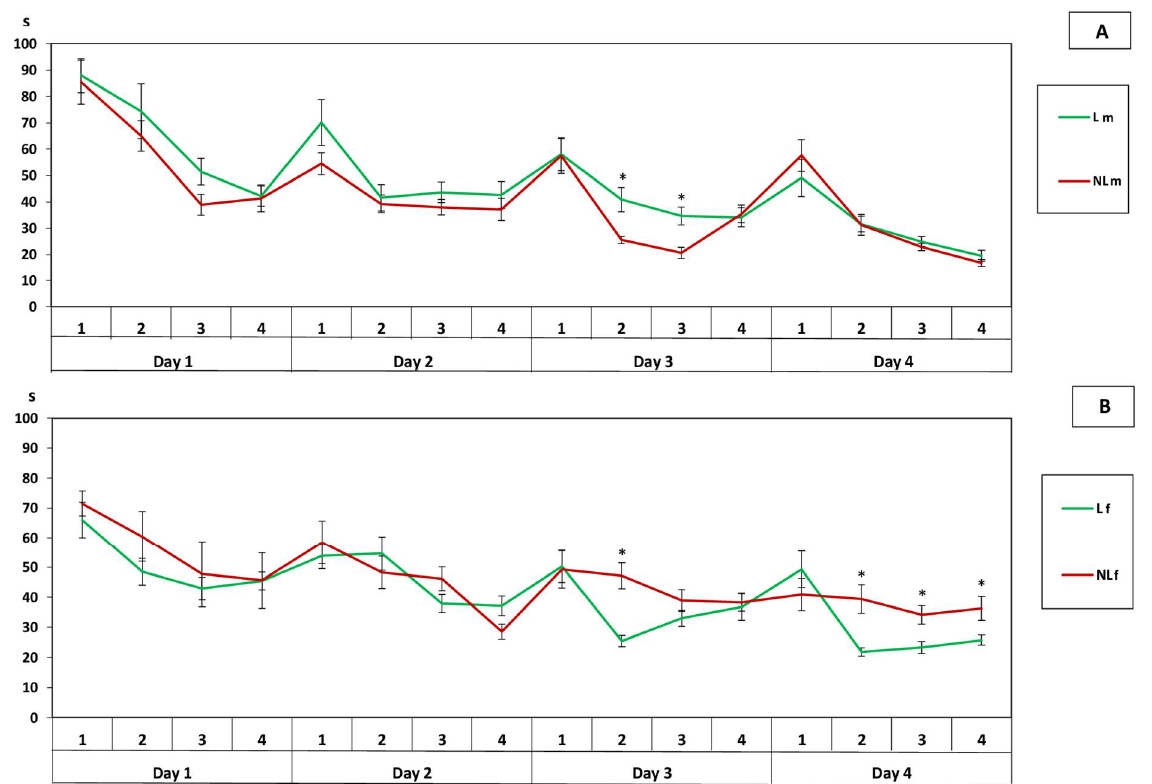
Figure 7. The latency period of reaching the underwater platform (( A )—2-month male rats; ( B )—2-month female rats). * p < 0.05 between L and NL rats.